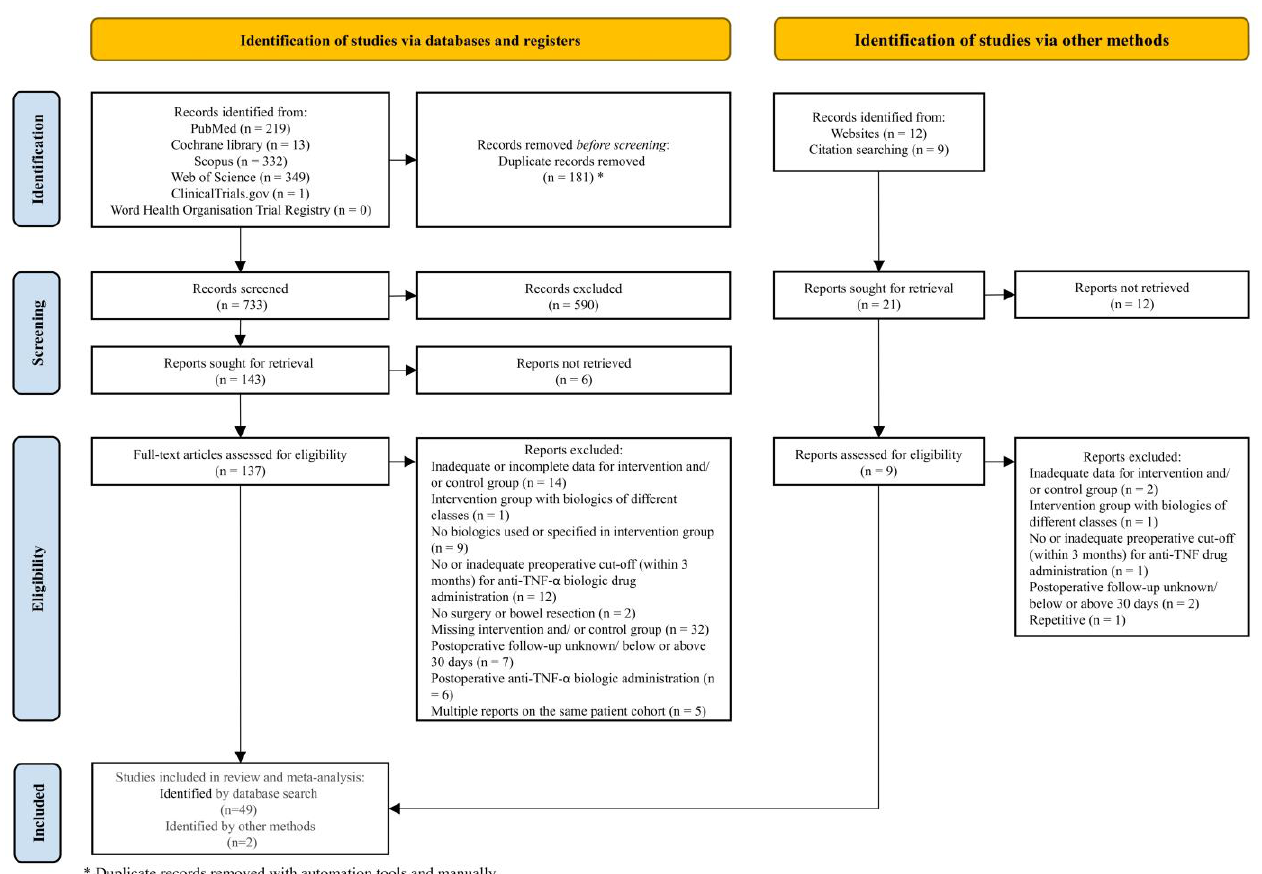
Figure 1. The study flow diagram according to the Preferred Reporting Items for Systematic Review and Meta-Analyses (PRISMA) Statement 2020 [20]. and Meta-Analyses (PRISMA) Statement 2020